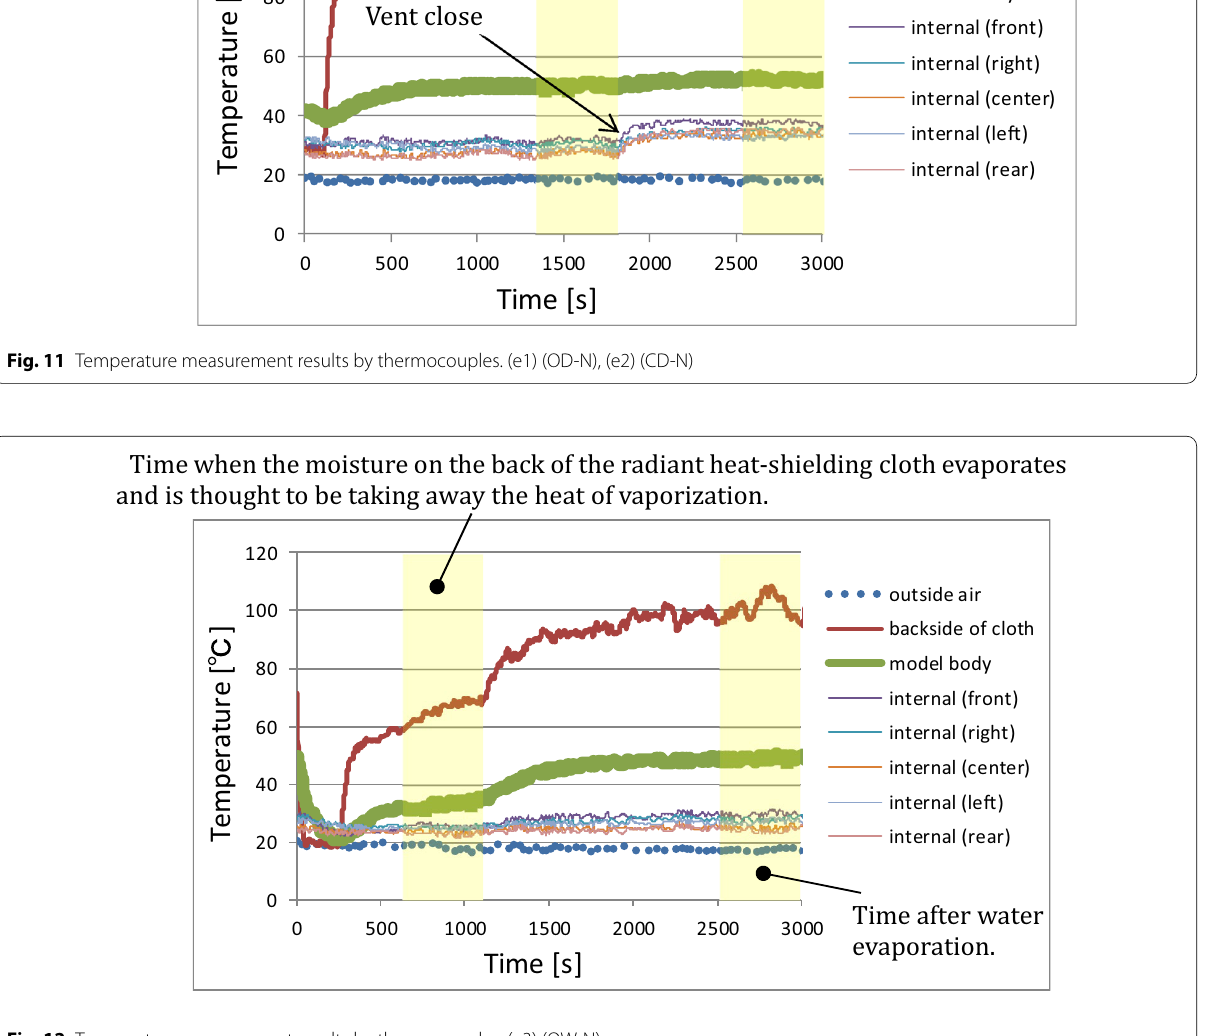
Fig. 12 Temperature measurement results by thermocouples. (e3)